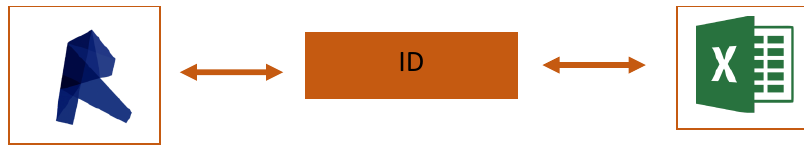
Figure 6. Information exchange through the ID.